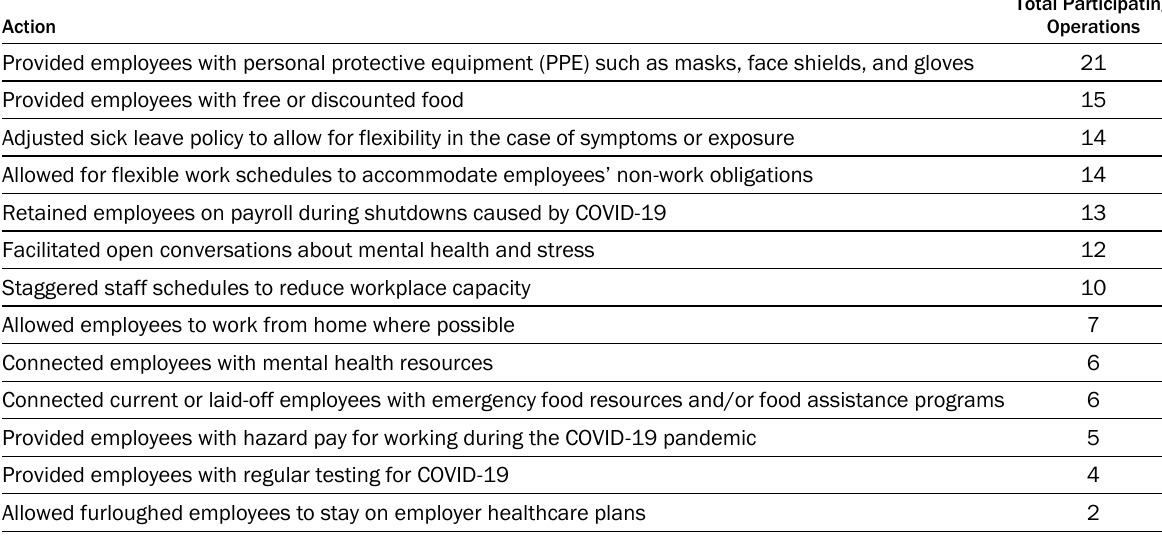
Table 5. Actions Taken by Foodservice Operations to Address Employee Health and Wellbeing Action